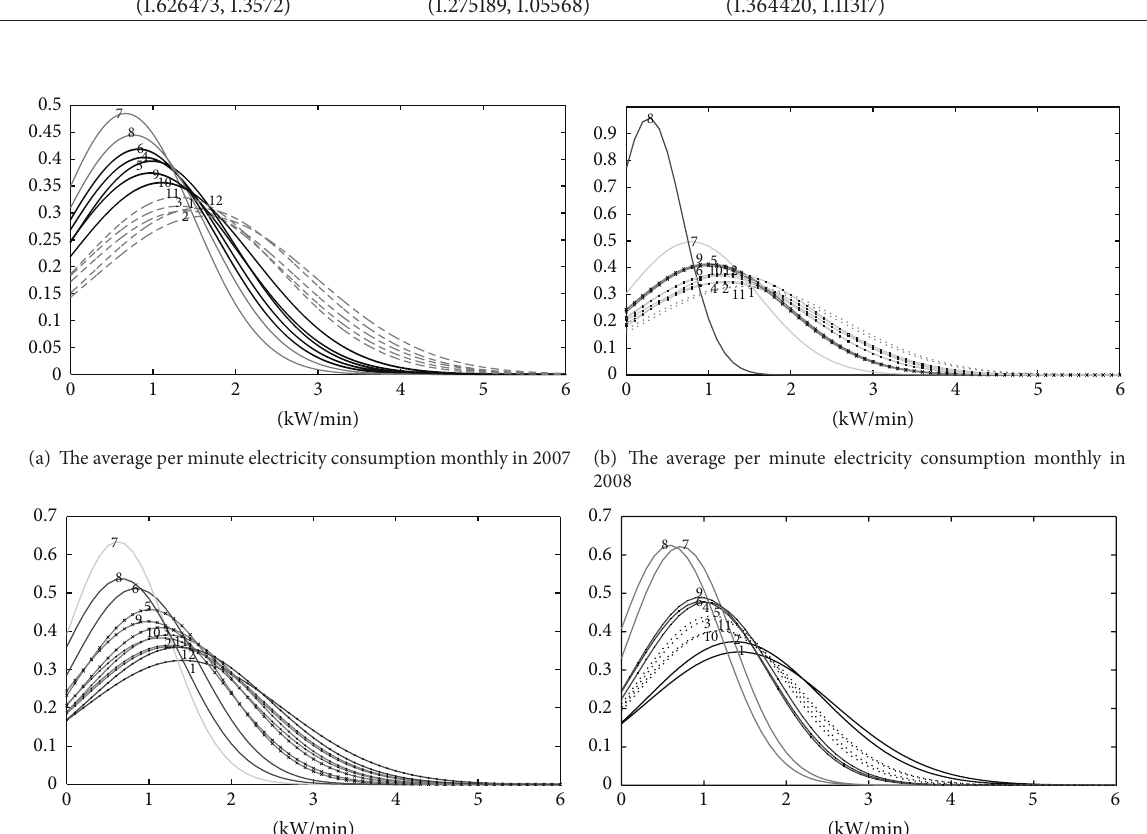
Figure 4: Cluster distribution of dataset